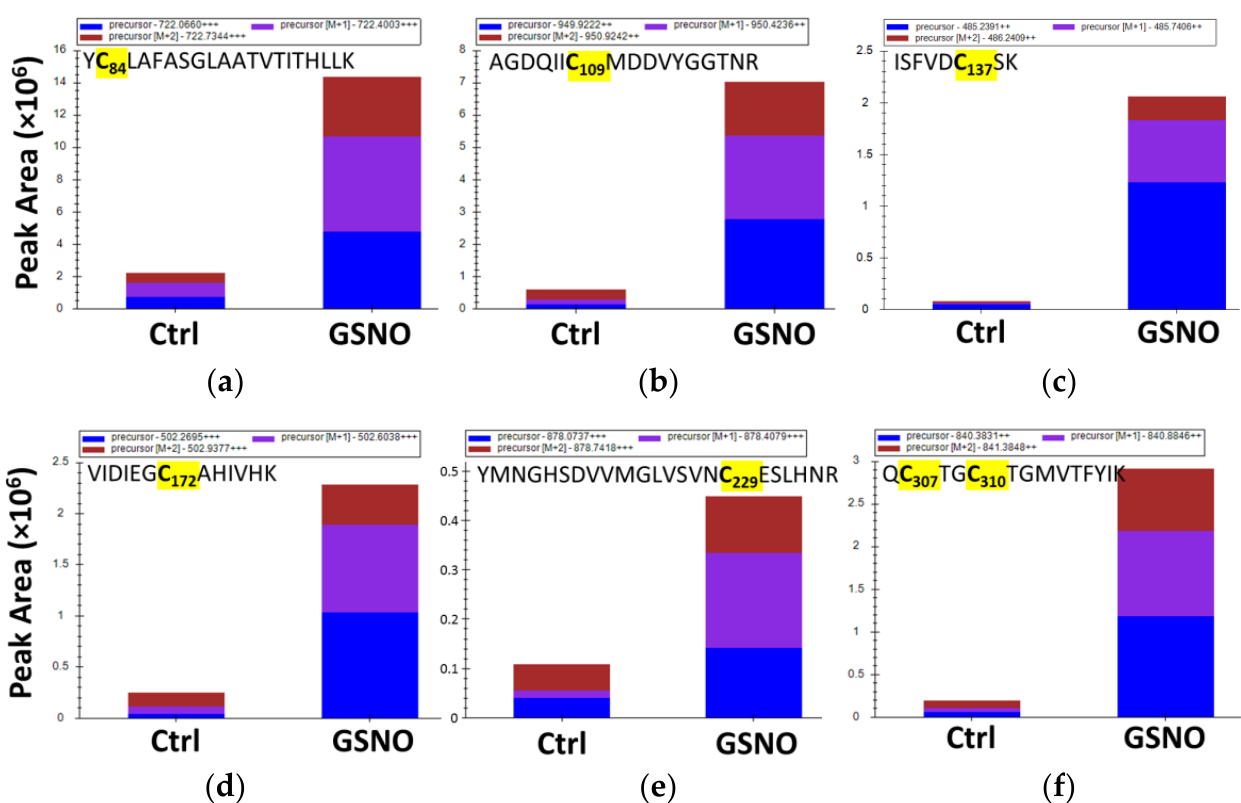
Figure 4. Identification of CSE buried S -nitrosated cysteine(s) by mass spectrometry. Comparison of peak areas from ions corresponding to the tryptic peptides containing Cys84 ( a ), Cys109 ( b ), Cys137 ( c ), Cys172 ( d ), Cys229 ( e ), and Cys307/Cys310 ( f ) with acrylamide (AA) incorporation, in GSNO-treated and Ctrl samples. The isotopic pattern ([M], [M + 1] and [M + 2] peaks) obtained is fully consistent with the one expected for the modified peptide.